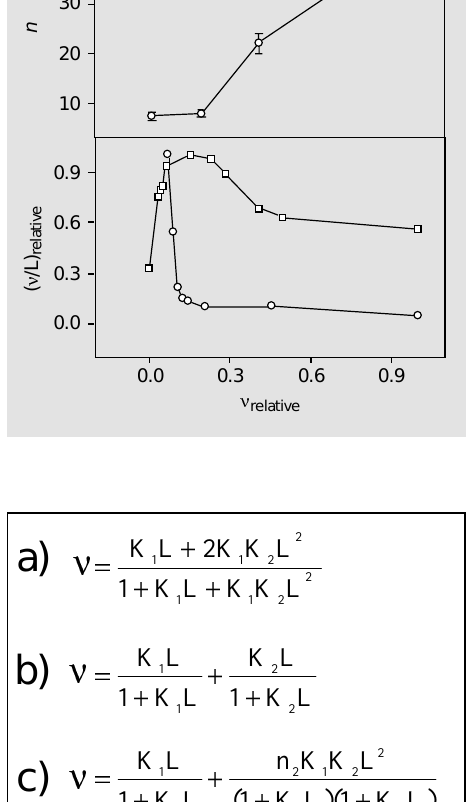
Figure 1. Binding of flavianate to trypsin at different incubation periods. Upper panel : n , maxi- mum molar ratio of binding with increasing incubation times of 18, 42, 70 and 139 h. Solutions of trypsin and flavianate were 21 µM and 0.8 mM, respectively. Lower panel : Scatchard plots of the interaction at incubation times of 18 (circles) and 139 h (squares); the values are relative to the maximal ones. Dye con- centration range was 1 µM to 0.8 mM with trypsin at 21 µM.